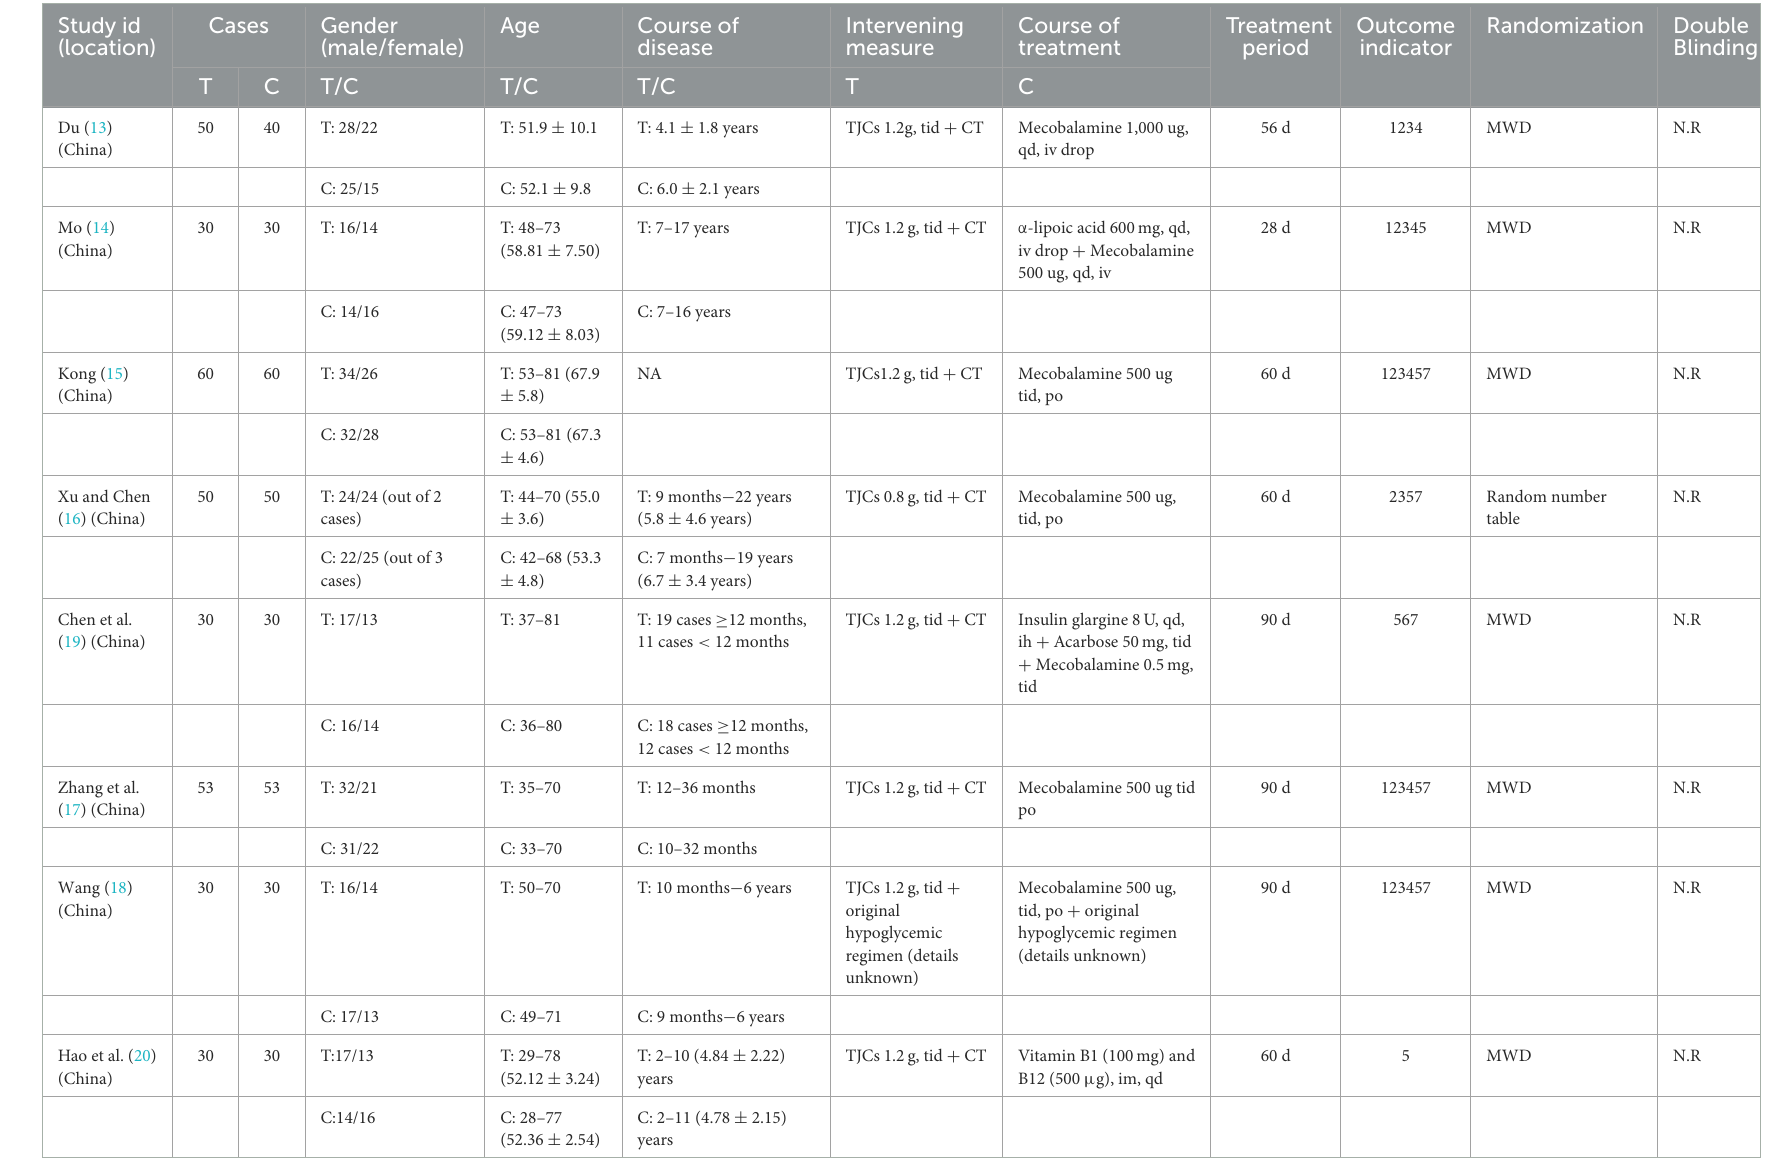
TABLE 2 Characteristics of included